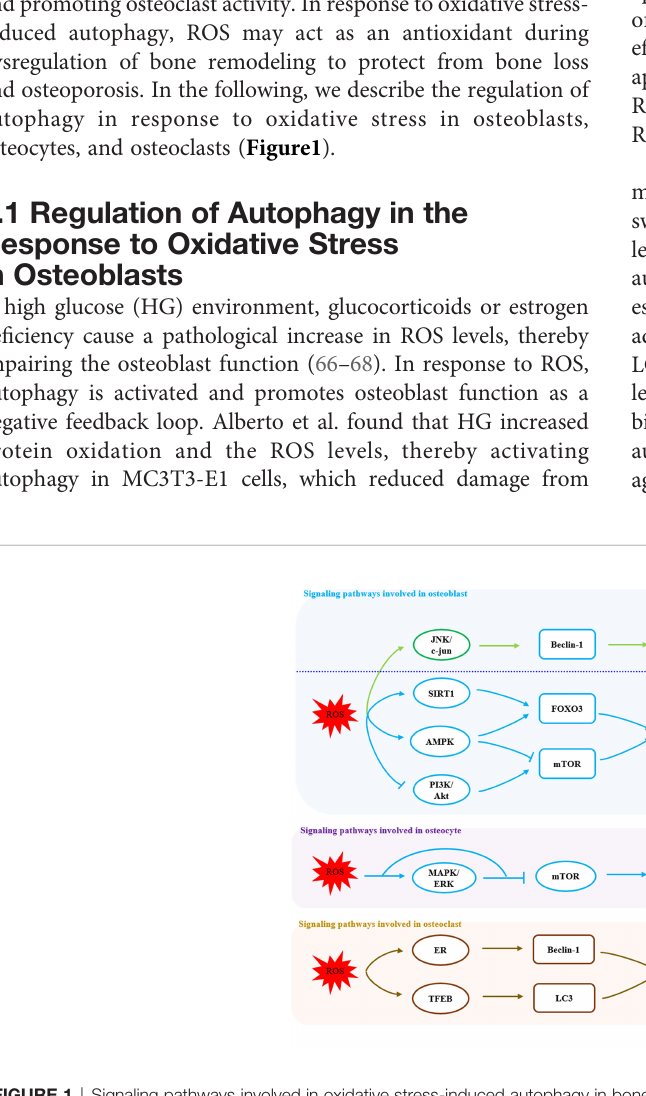
FIGURE 1 | Signaling pathways involved in oxidative stress-induced autophagy in bone remodeling. In osteoblasts, ROS induced an excessive increase in Beclin-1 levels by activation of the JNK/c-jun pathway, which triggered excessive autophagy, exacerbated osteoblasts apoptosis, and reduced bone formation. On the other hand, oxidative stress activates protective autophagy through ROS/SIRT1/FOXO3, ROS/AMPK/FOXO3, ROS/AMPK/mTOR and ROS/PI3K/Akt/mTOR pathways to remove excessive ROS within a certain range, promoting the survival of osteoblasts and increasing bone formation. Likewise in osteoblasts, oxidative stress-induced protective autophagy is also present in osteocytes, which is achieved by ROS/MAPK/ERK/mTOR pathway. In osteoclasts, Oxidative stress-induced autophagy promotes osteoclastogenesis and bone resorption through the ROS/ER and ROS/TFEB